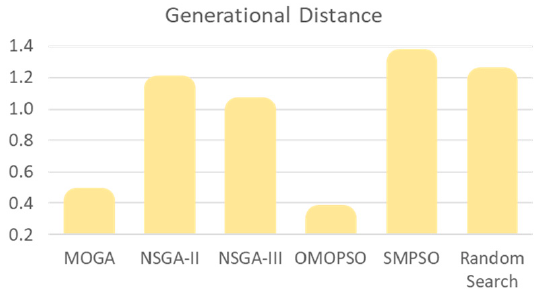
Figure 11. Average GD to the Pareto’s ideal front by each algorithm.